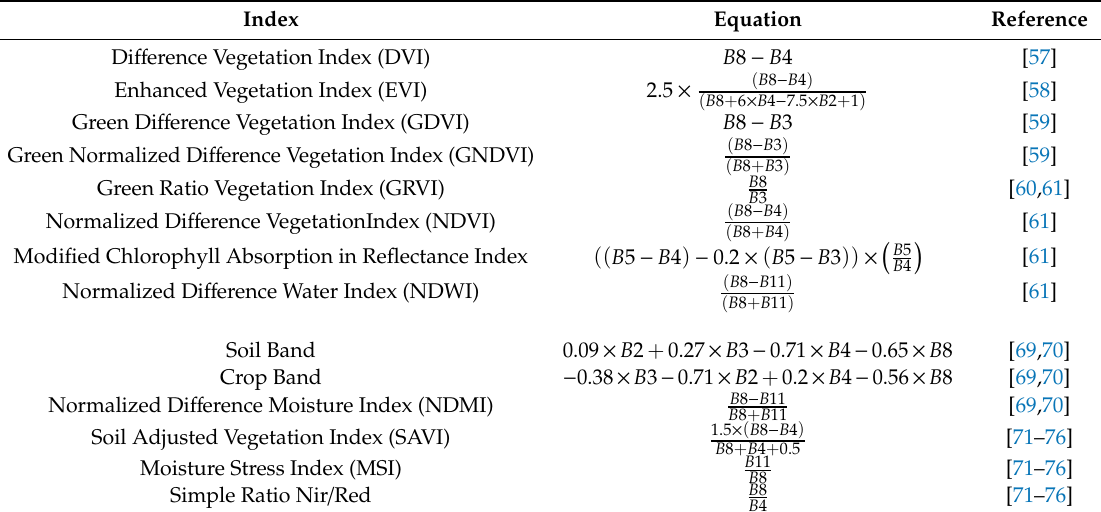
Table 2. Sentinel-2